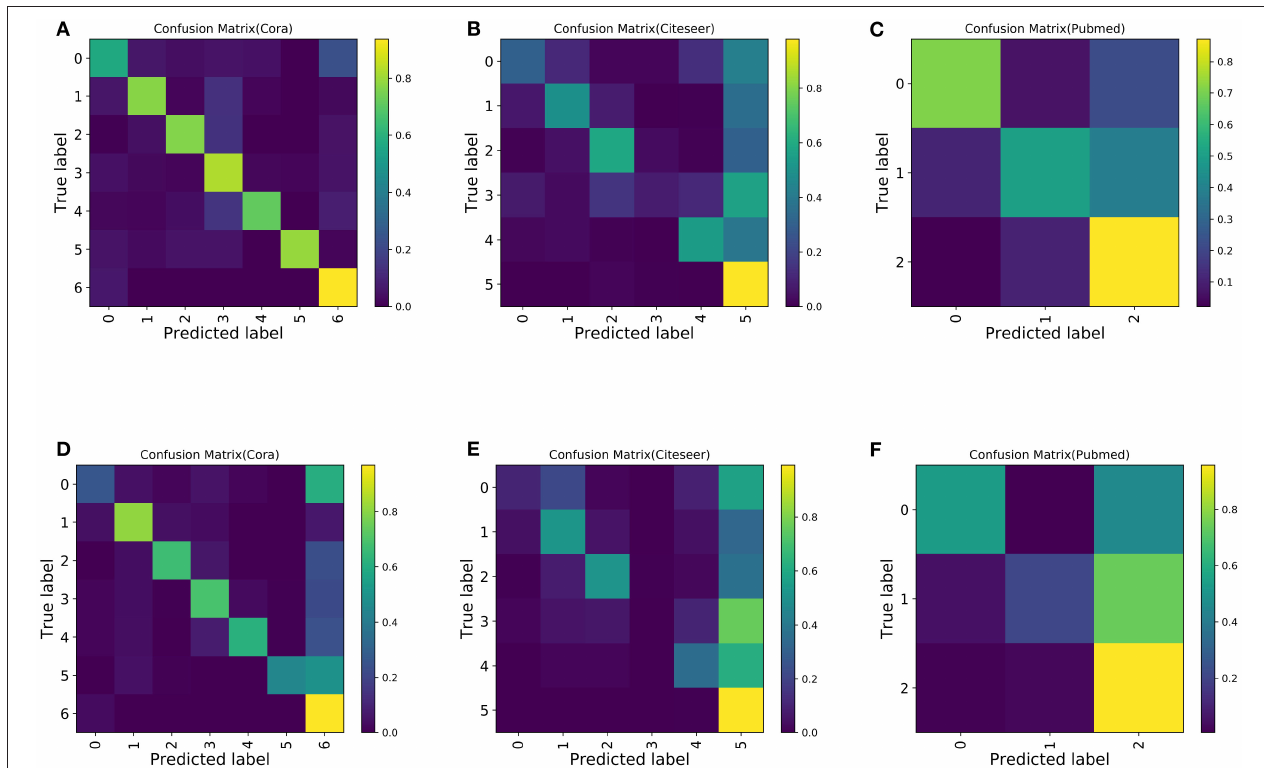
FIGURE 6 | Confusion matrix for the Cora, Pubmed, and Citeseer datasets with 30 labeled nodes for majority class and five labeled nodes for the minority class. (A) Boosting-GCN on Cora. (B) Boosting-GCN on Citeseer. (C) Boosting-GCN on Pubmed. (D) GCN on Cora. (E) GCN on Citeseer. (F) GCN on Pubmed.